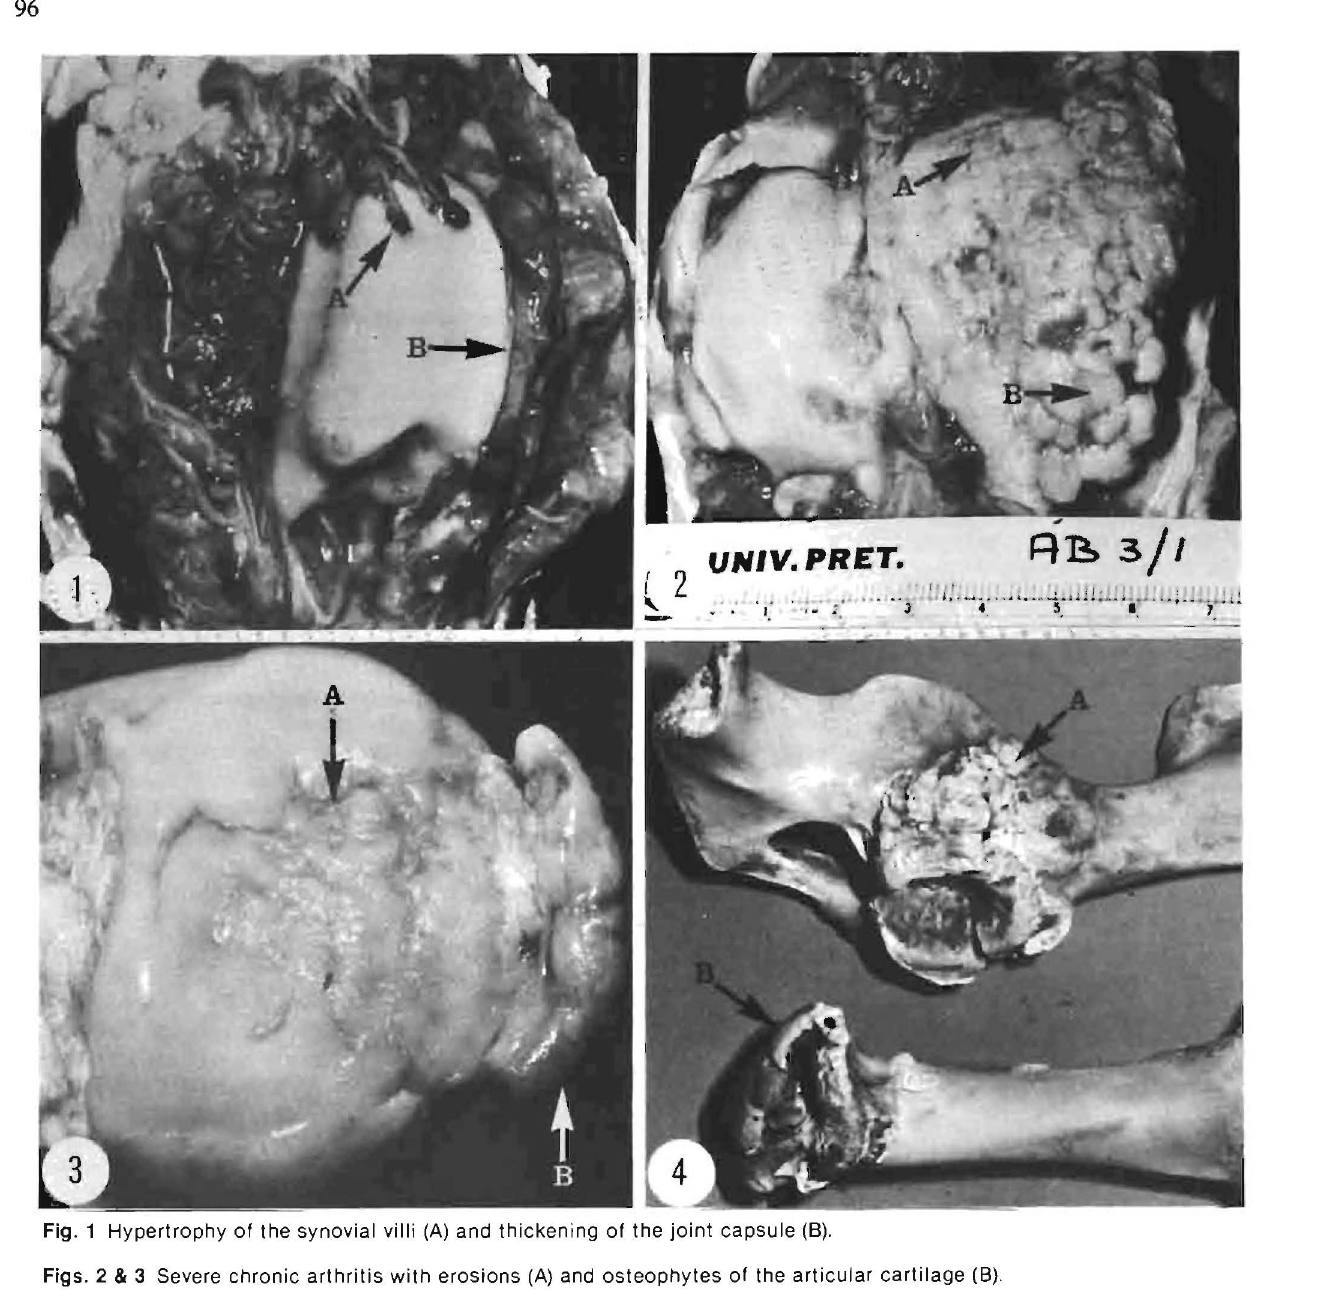
Fig. 1 Hypertrophy of the synovial villi (A) and thickening of the joint capsule (8). Figs. 2 & 3 Severe chronic arthritis with erosions (A) and osteophytes of the articular cartilage (B). Ftg.4 Bony structures of arthritic hip joint after removal of soft tissues. Osteophyte formation (A) and severe eroding of fermoral head